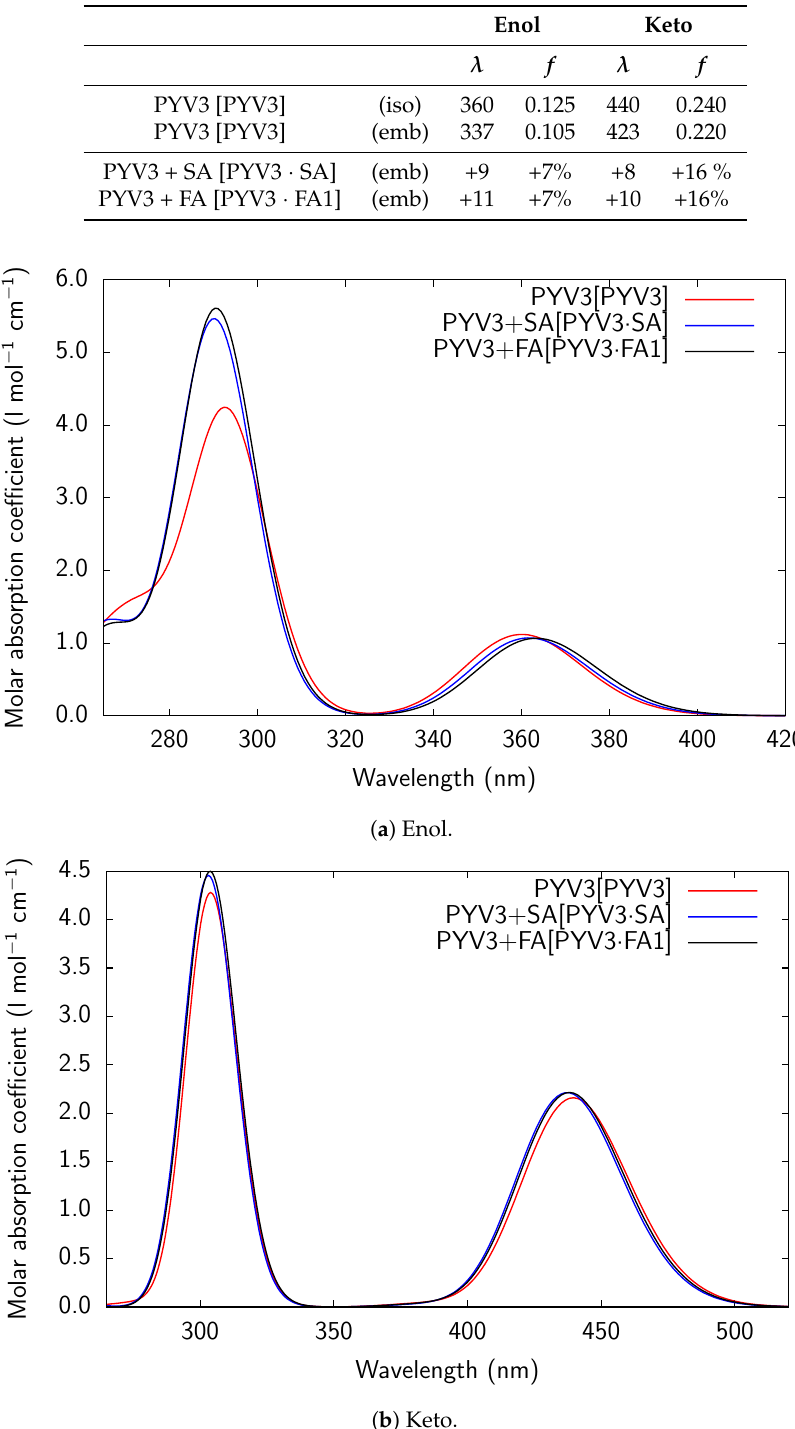
Table 3. RI-CC2/def2-TZVPD first wavelengths of excitation ( λ , in nm) and oscillator strengths ( f ) for the isolated (iso) and embedded (emb) monomer of PYV3 (PYV3 [PYV3]) and the variations for the